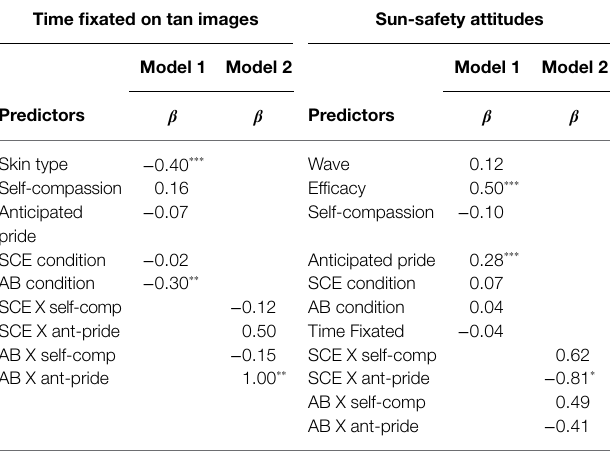
TABLE 2 | Standardized beta coefficients of the stepwise regressions. Time fixated on tan